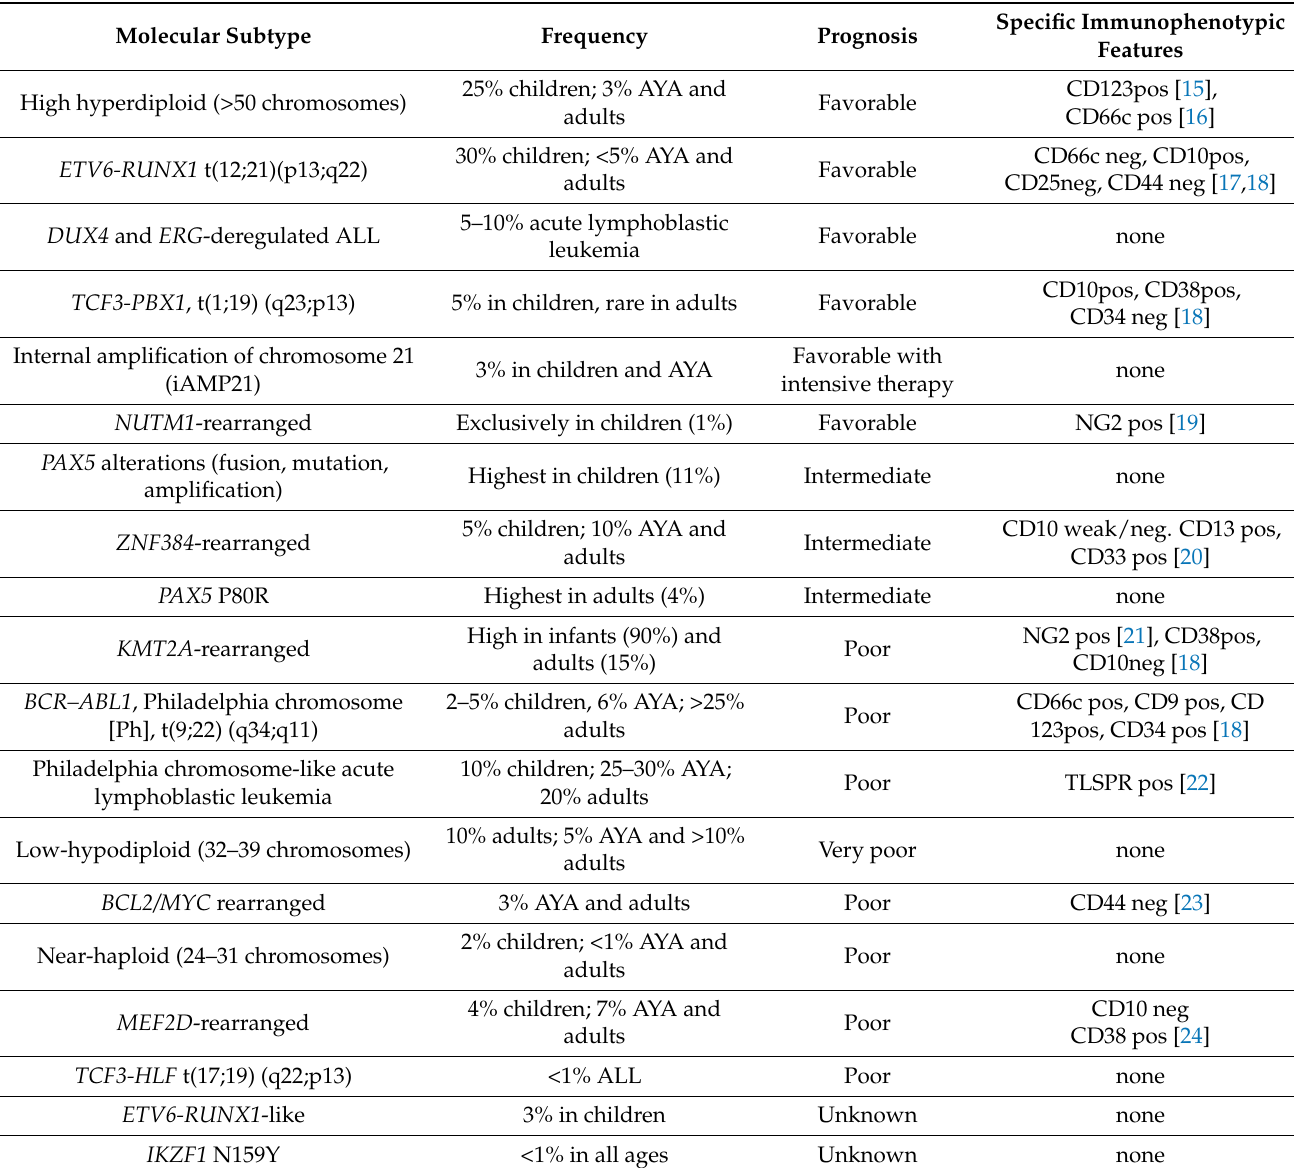
Table 1. Molecular subtypes of B cell precursor acute lymphoblastic leukemia